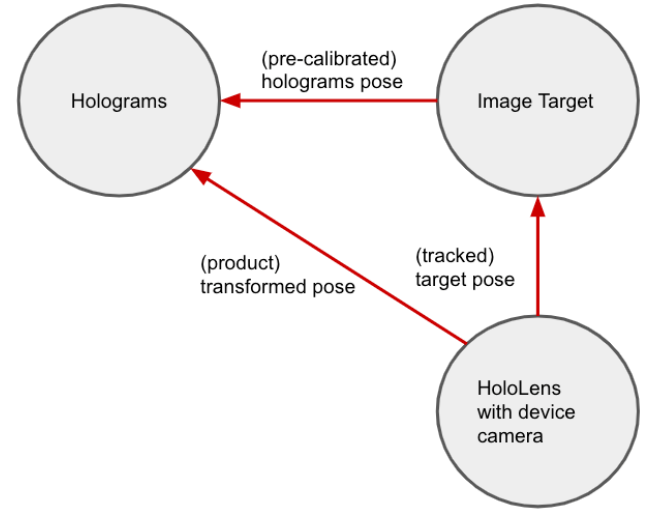
Figure 7. Spatial Relationship Graph (SRG) of the registration setup: we got the spatial transformation between holograms and the HoloLens device through their relations with the image target .